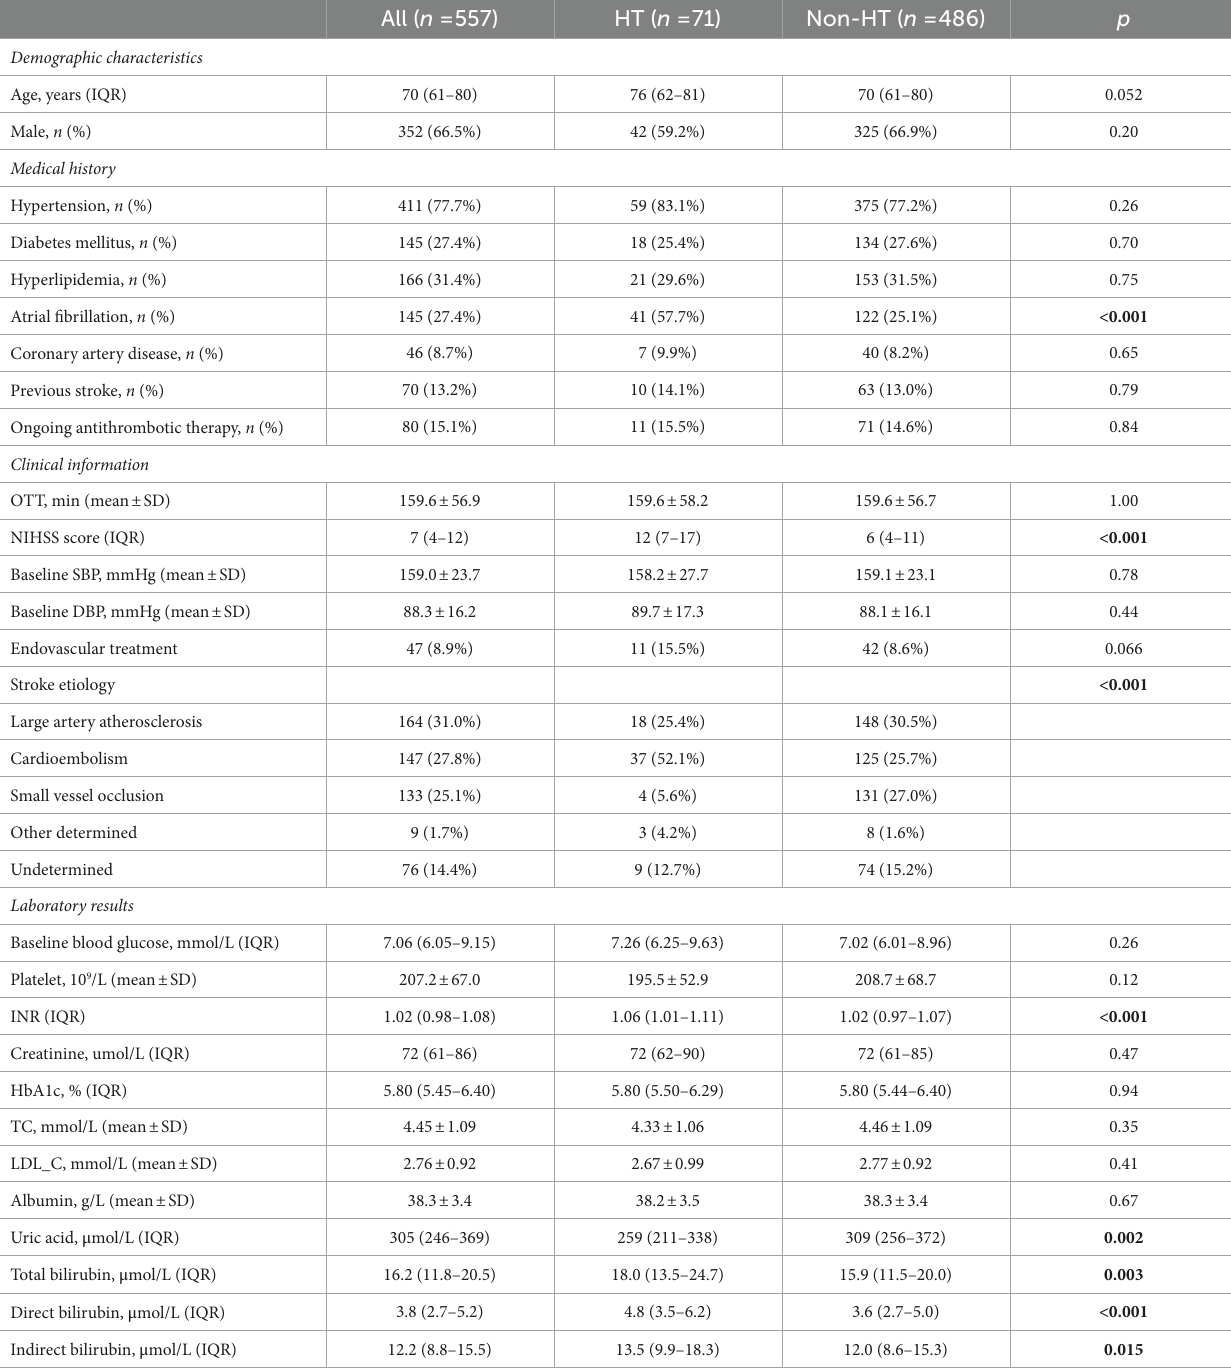
TABLE 1 Clinical characteristics of patients, stratified by the presence of HT. All ( n = 557) HT ( n = 71) Non-HT ( n = 486)